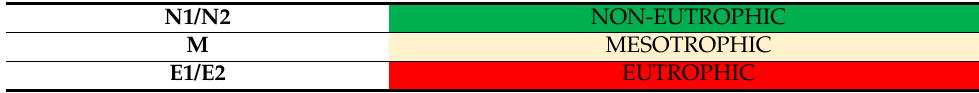
Table 4. Integrated TWEAM outcomes of phase 2. N1/N2